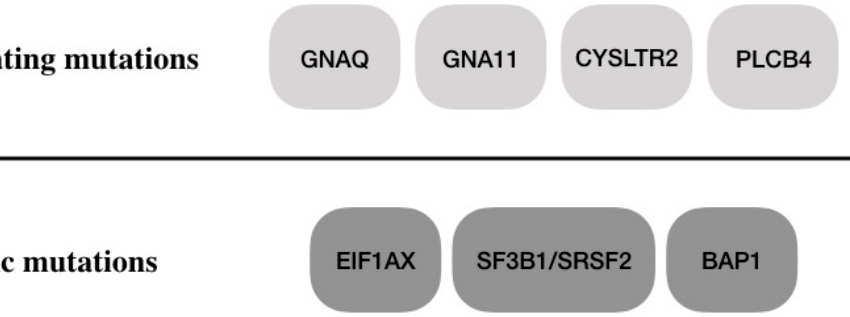
Figure 1. Two layers of mutations in uveal melanoma (UM) . Mutations in genes involved in G-protein signaling are present in 98% of samples in a nearly mutually exclusive